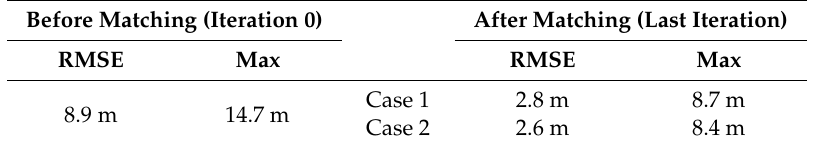
Table 5. Distances between GCPs and DEM before and after point-to-surface matching.